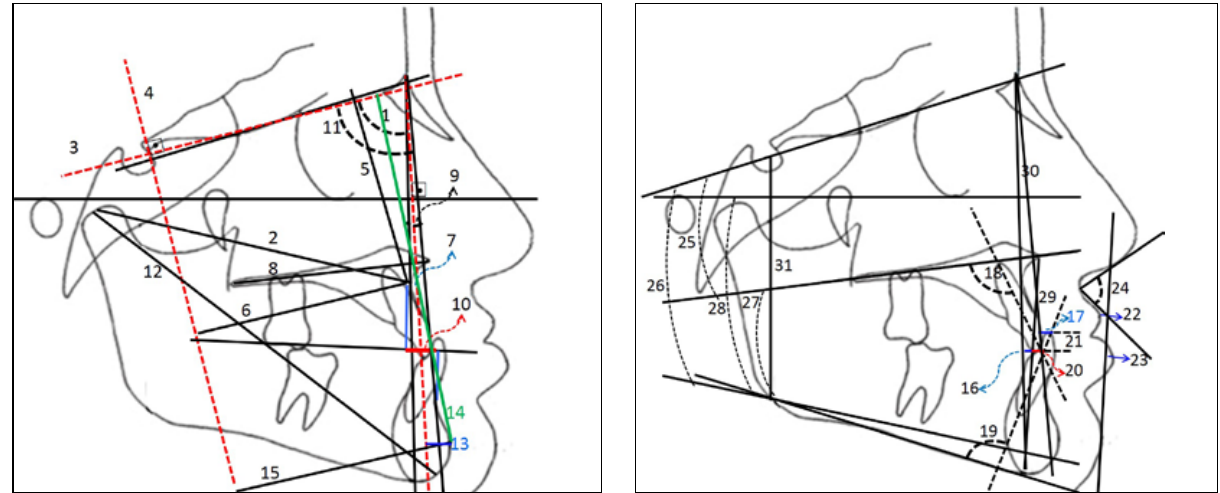
Figure 1. Class III elastics used between micro-implants and miniplates and removable appliance used to bite jump in SA group.